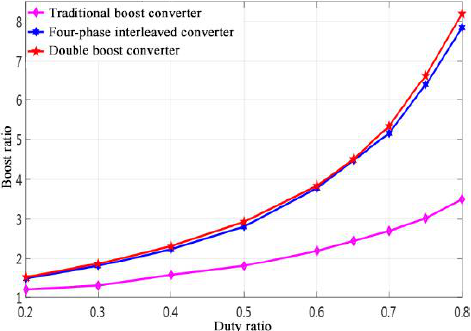
Figure 15. Comparison curve of measured boost ratio.